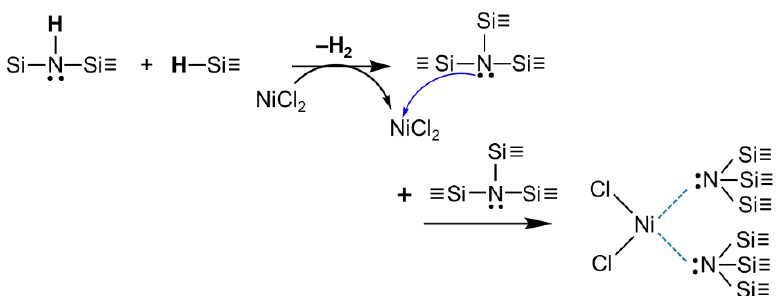
Figure 1. ATR-FTIR spectra of as-received PHPS (black line) and Ni-modified PHPS samples (red and blue lines represent the Ni/Si atomic ratios of 0.05 and 0.2, respectively): ( a ) 600 – 4000 cm − 1 and ( b ) 600 – 1100 cm − 1 .